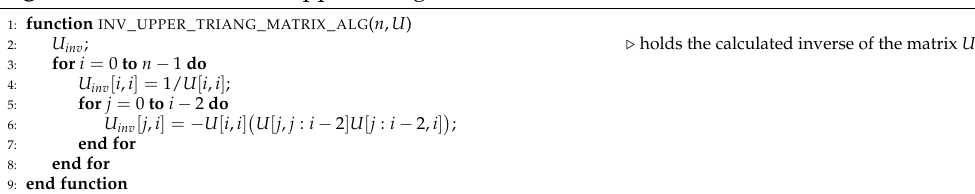
Algorithm 3 Inverse of an upper triangular